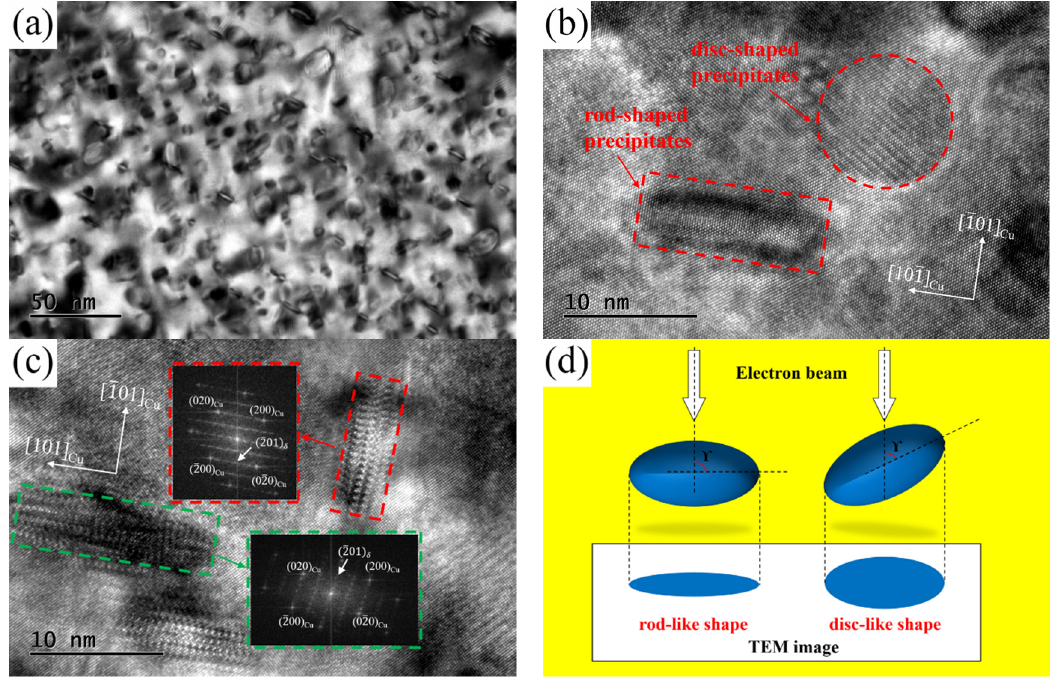
Figure 9. TEM and high resolution transmission electron microscopy (HRTEM) images of the NS ‐ 4 alloy aged at 500 °C for 2 h. ( a ) Bright ‐ field TEM image along [110] Cu , ( b ) HRTEM images, ( c ) HRTEM images along [001] Cu , and ( d ) morphology of the precipitated phase.